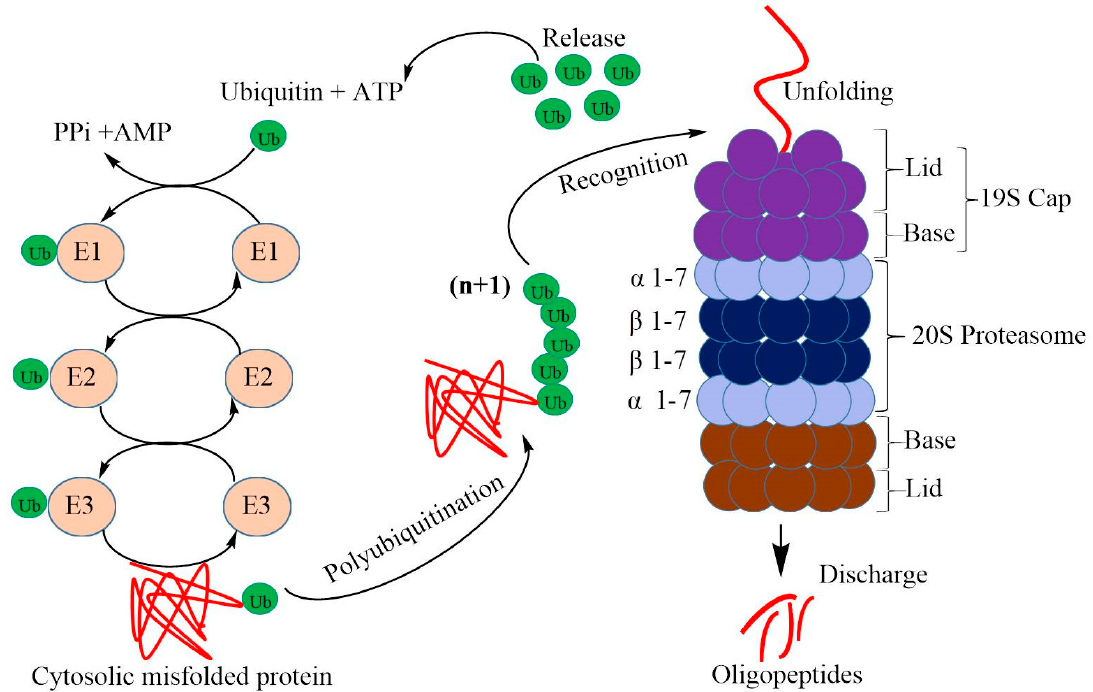
Figure 1. Schematic representation of ATP-powered proteolysis in the cytosol of plant cells. Proteins are tagged with multi-ubiquitin chains by the action of a series of ubiquitin ligases (E1, E2, and E3) and are targeted for degradation by the 26S proteasome. The 26S proteasome consists of the 20S proteasome sandwiched between two 19S regulatory particles. Upon binding of the protein substrate to the 26S proteasome, ubiquitin chains are recycled, and the protein is unfolded and degraded to oligopeptide fragments. E1: ubiquitin-ligase enzyme; E2: ubiquitin-conjugating enzyme; E3: ubiquitin-ligating enzyme.